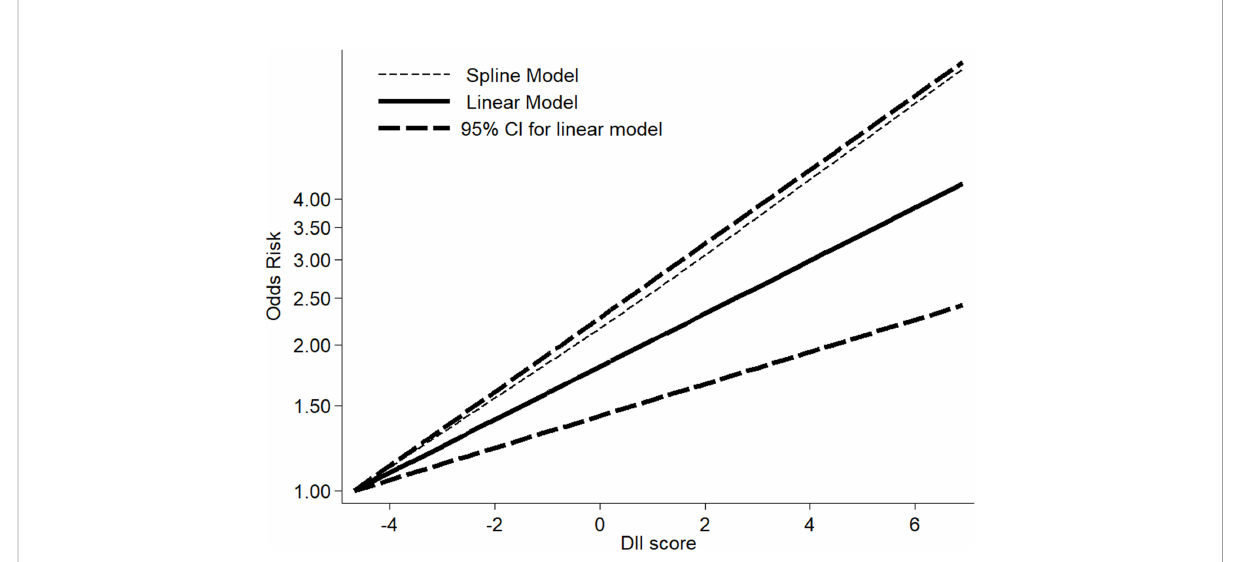
FIGURE 4 Linear and non-linear dose – response relationship between DII and risk of oral cancer.